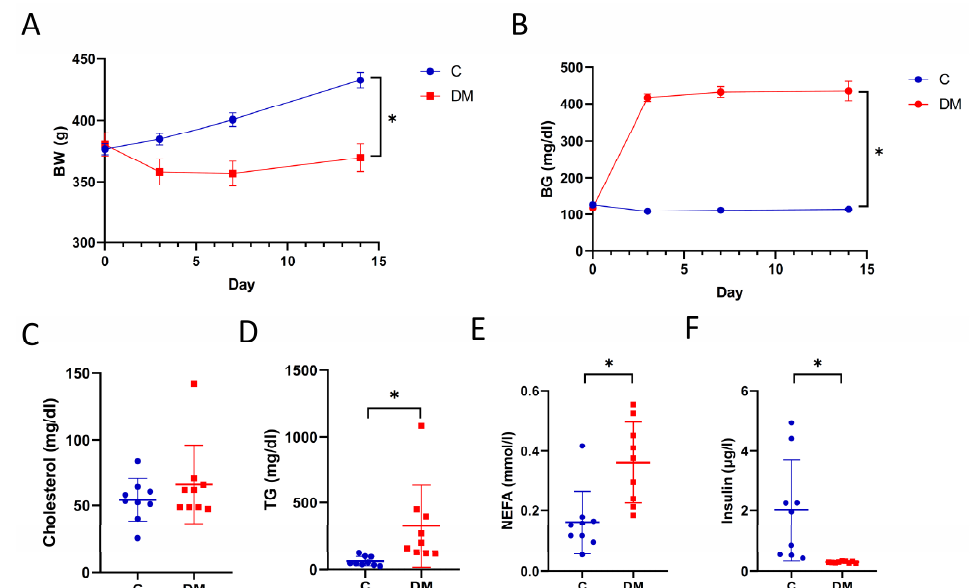
Figure 1. STZ-induced T1DM. ( A ) Body weight—BW. ( B ) Blood glucose—BG. ( C ) Plasma cholesterol levels. ( D ) Plasma TG levels. ( E ) Plasma non-esterified fatty acids, NEFA levels. ( F ) Plasma insulin levels. Data are expressed as mean ± SEM ( n = 9). p -values were determined by Student’s t -test. * p < 0.05 DM vs. C.